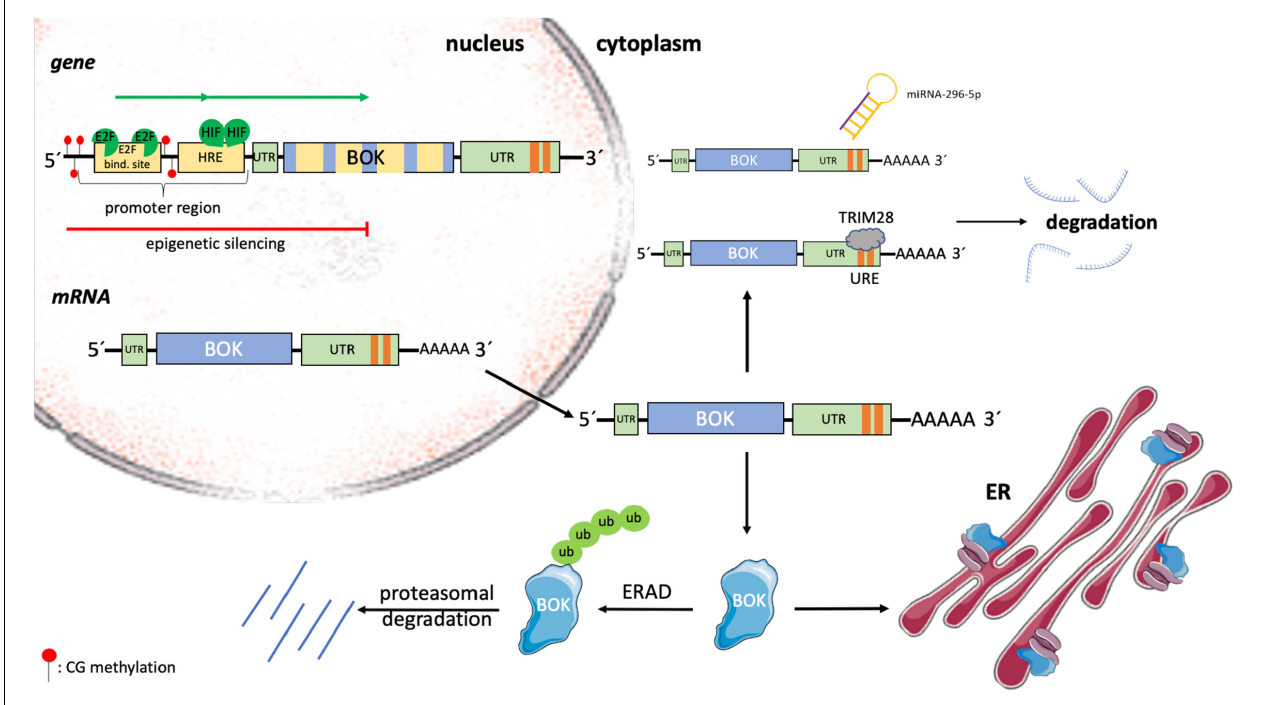
FIGURE 3 | Transcriptional and posttranslational regulation of BOK. The expression of BOK is regulated at transcriptional, epigenetic, translational, and posttranslational levels. In a variety of human cancers, the genomic region containing the BOK locus on chromosome 2 is deleted. Within its promoter region, BOK contains HREs, as well as a conserved E2F1-binding site. Upon binding by hypoxia-inducible factors (HIFs) and the cell cycle–regulating transcription factor E2F1, respectively, BOK transcription is induced. On the other hand, by means of promoter methylation, BOK can be epigenetically silenced. BOK comprises five exons. Alternative splicing leads to the development of the poorly understood BOK isoforms BOK-S and BOK-P. The expression of BOK is furthermore regulated at the level of mRNA stability. The miRNA miR-296-5p has been shown to bind to the 3’ UTR of BOK mRNA, leading to its degradation. Moreover, strongly destabilizing (AU/U)–rich elements (one ARE site in mouse Bok mRNA, two URE sites in human BOK mRNA) were described in the 3’ UTR of BOK. Tripartite motif containing 28 (TRIM28) was identified to bind to this region, leading to destabilization and subsequent degradation of human BOK mRNA. Once translated, BOK is mainly localized at ER membranes, where it is bound to IP3Rs. Unbound BOK is quickly turned over by the ERAD pathway, resulting in ubiquitin-proteasomal